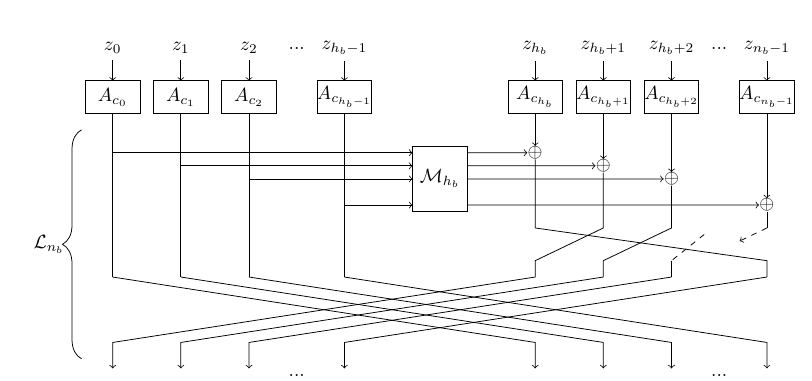
Figure 1: The overall structure of a step of Sparkle . 𝑧